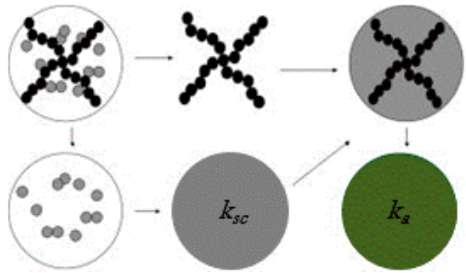
Figure 11. Schematic picture of the aggregate structure formed by nanoparticles arranged in a linear chain ( black ) and sidechains ( gray ). The conductivity of the whole aggregate ( k g ) is calculated by considering the conductivity of the backbone nanoparticles embedded in a medium with an effective conductivity k sc , due to the surrounding presence in the fluid of the sidechain nanoparticles. Adapted with permission from [231], Copyright 2006, AIP Publishing.